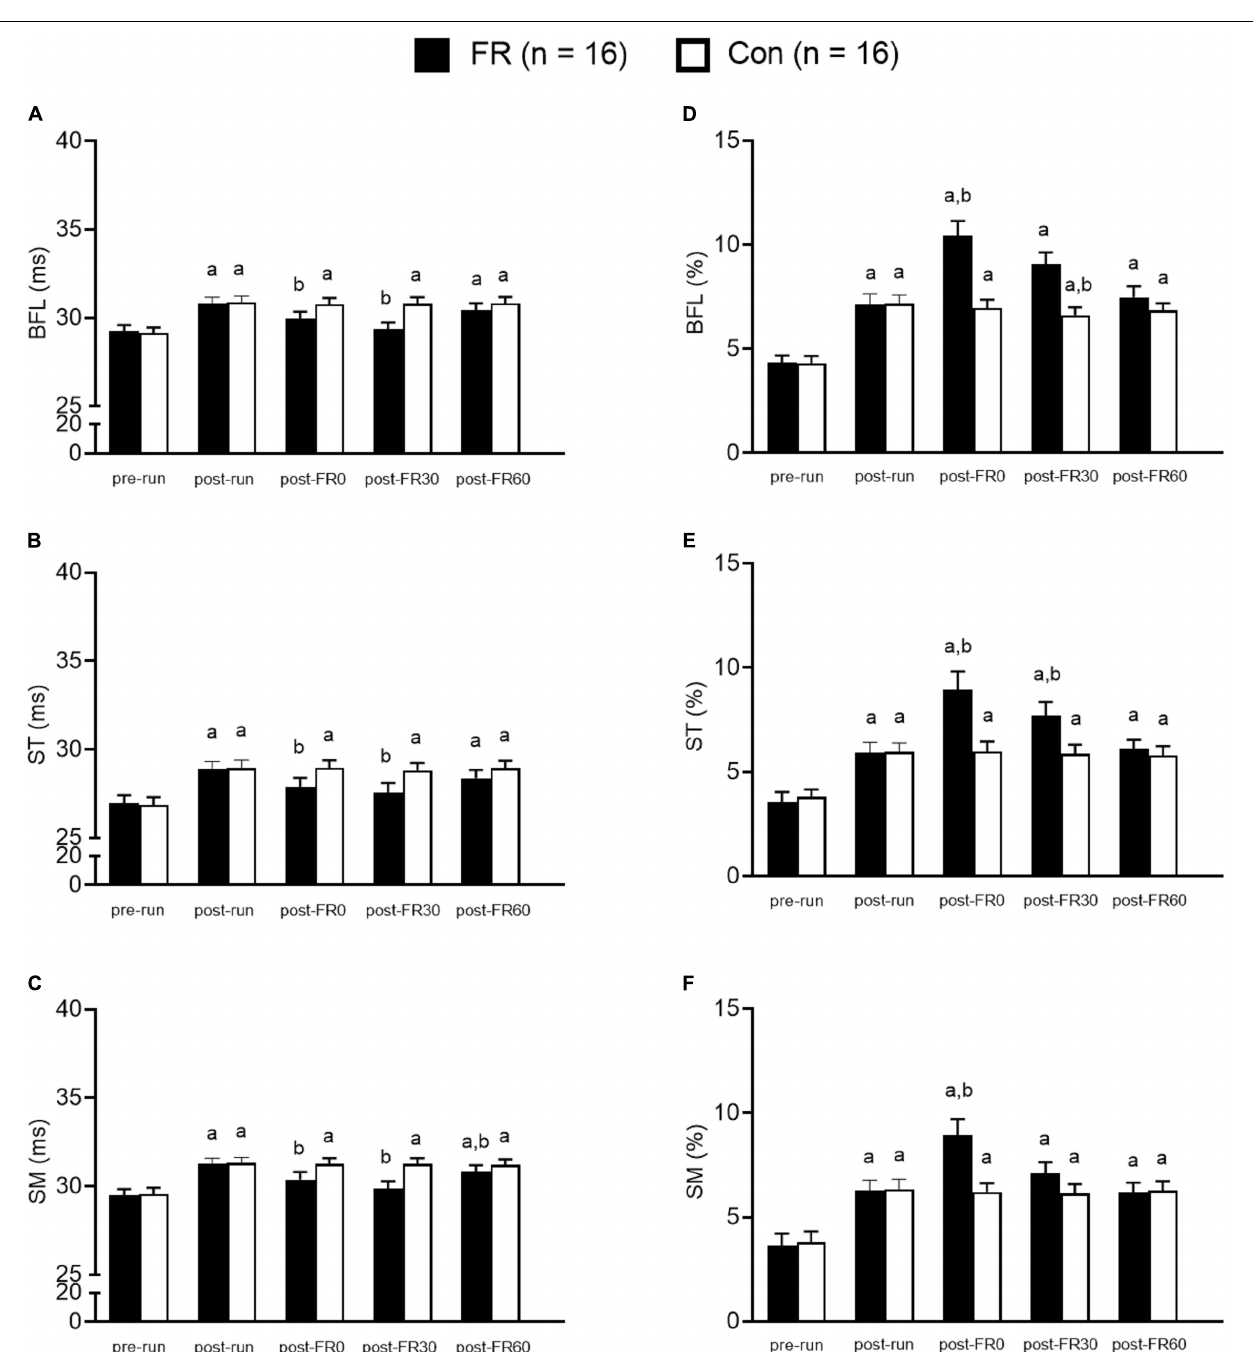
FIGURE 4 | Bar graphs showing muscle functional magnetic resonance imaging results for foam rolling (FR) side and control (CON) side for the hamstring muscles at five different time points. (A–C) The T2 value changes from T2 mapping sequence. Panels (D–F) show f value changes from intravoxel incoherent motion sequence. BFL, biceps femoris long head; ST, semitendinosus; SM, semimembranosus; pre-run, baseline; post-run, 2–3 h after half-marathon running; post-FR0, immediately following FR intervention; post-FR30, 30 min after FR; post-FR60, 60 min after FR. a Time effect for each single time point vs. pre-run within each group; b time effect for each single time point vs. post-run within each group. Data are presented as Mean ± SE.